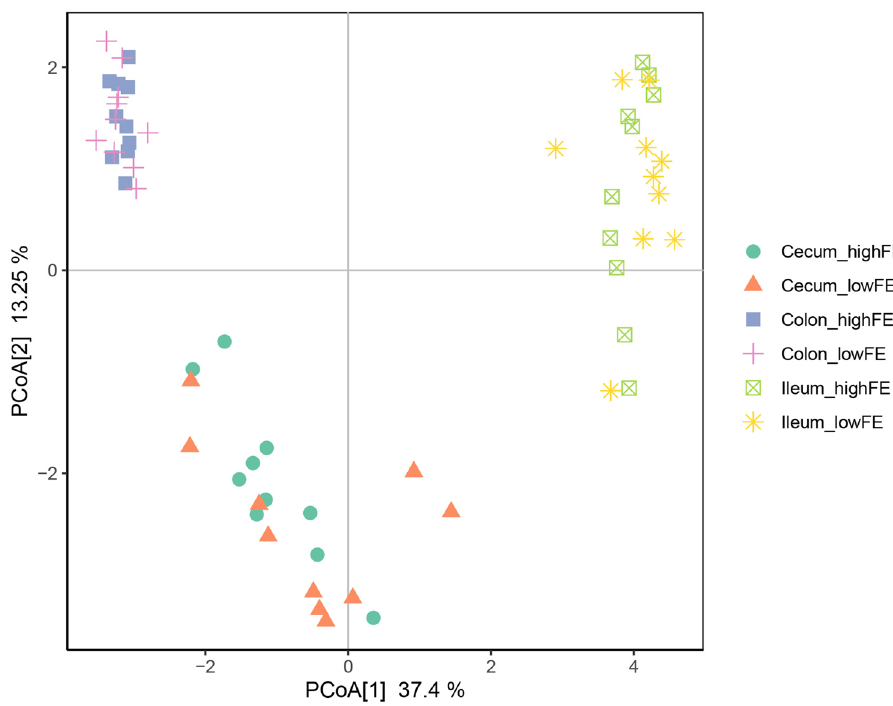
Figure 2. PCoA of the metabolites from distinct FCR groups.